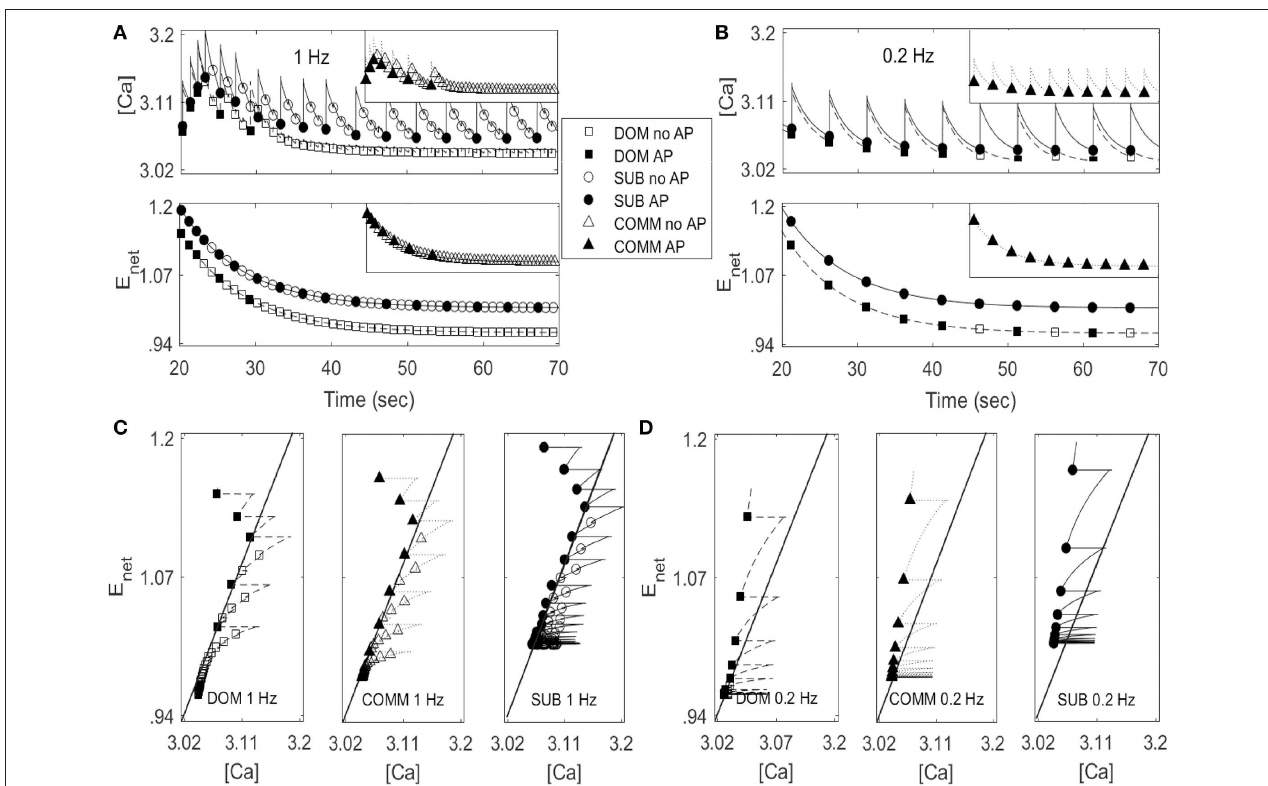
FIGURE 5 | Activity patterns of [Ca] and E net in dominant-like case (DOM) (lower curves with square symbols) and subordinate-like case (SUB) (upper curves with circle symbols) under periodic inputs at 1Hz (A) and 0.2Hz (B) . Insect in each panel in (A,B) show activity patterns of [Ca] and E net in communal-like case (COMM) (triangle symbols) in a half-size scale. These activity patterns lie in between DOM and SUB. Circle, triangle, and square symbols denote the moments when inputs are given. Closed symbols denote that the cell fires action potentials (AP) accordingly while open symbols denote no action potential (no AP). (C,D) ([Ca], E net )-space with the projection of the solution trajectory in DOM (left panel), COMM (middle panel), and in SUB (right panel) at 1Hz (C) and 0.2Hz (D) . The solid straight line that cuts the figure from lower left to upper right is the jump-up